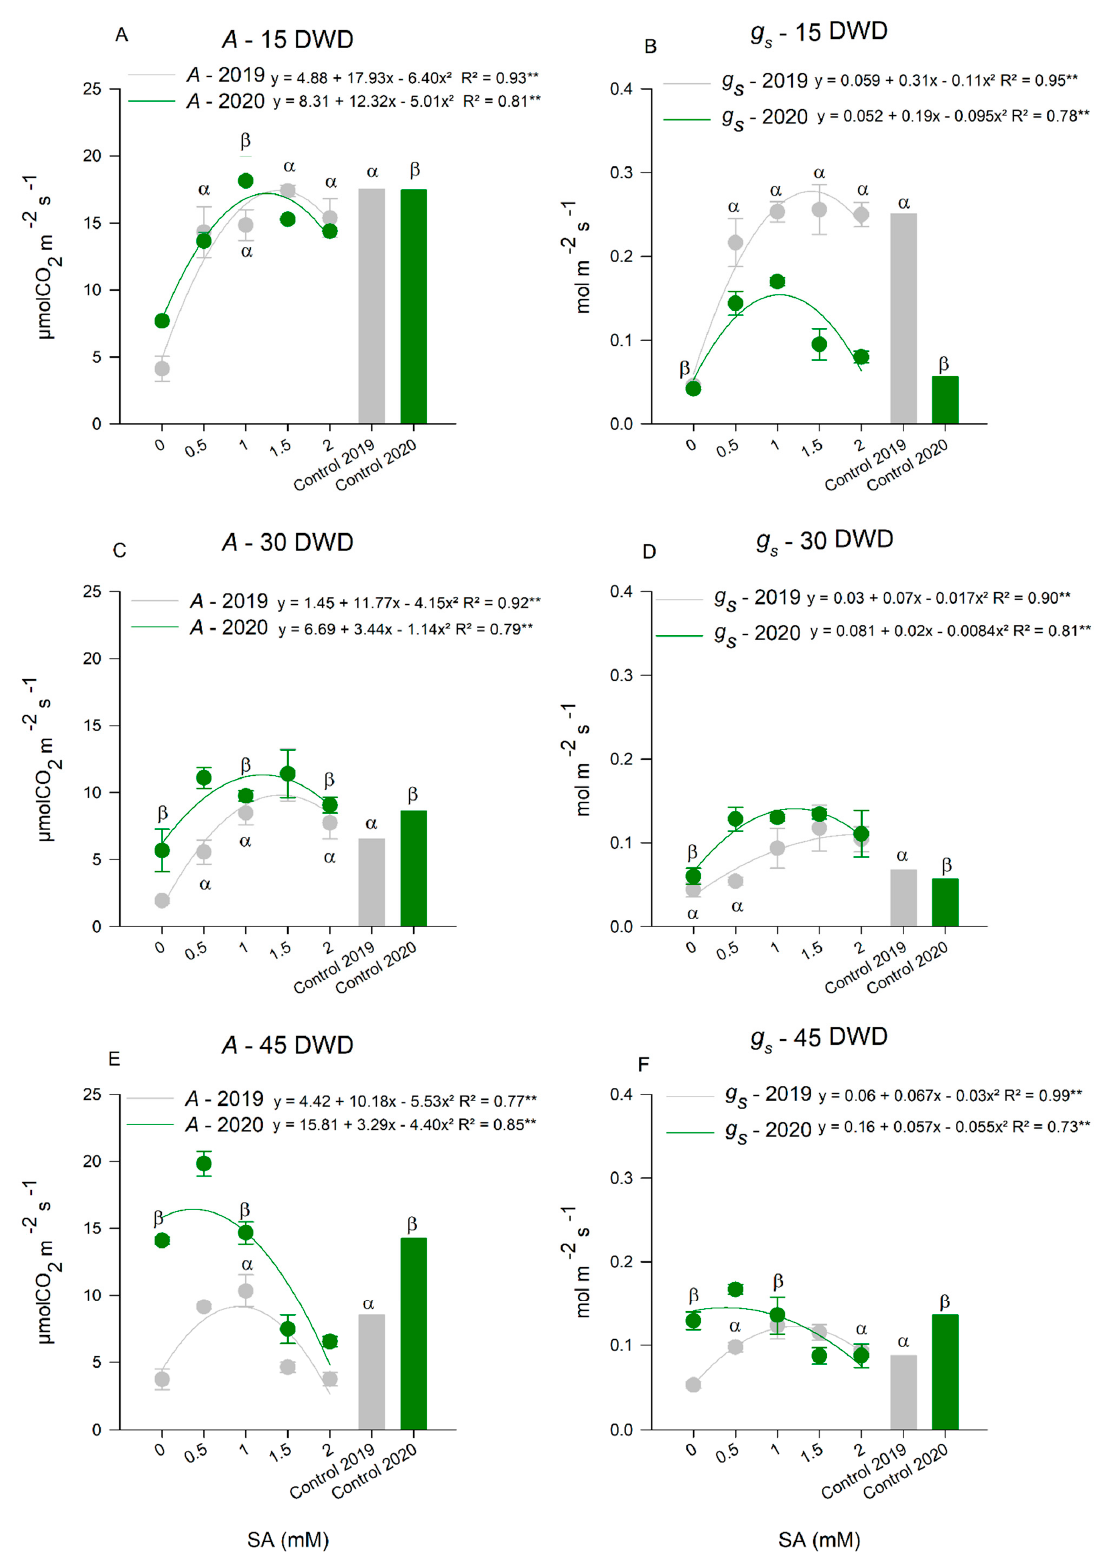
Figure 2. CO 2 assimilation rate ( A ) at 15 ( A ), 30 ( C ), and 45 ( E ) days of water deficit (DWD); stomatal conductance (g s ) at 15 ( B ), 30 ( D ), and 45 ( F ) DWD in tomato plants subjected to application of salicylic acid (SA) doses in two consecutive years, 2019 and 2020. ** Highly Significant at 5% probability. α Indicates an equal and significant effect between treatments by Dunnett’s Test at 5% probability in the 2019 cycle and β in the 2020 cycle. The bars show the standard deviation. n = 4 (number of